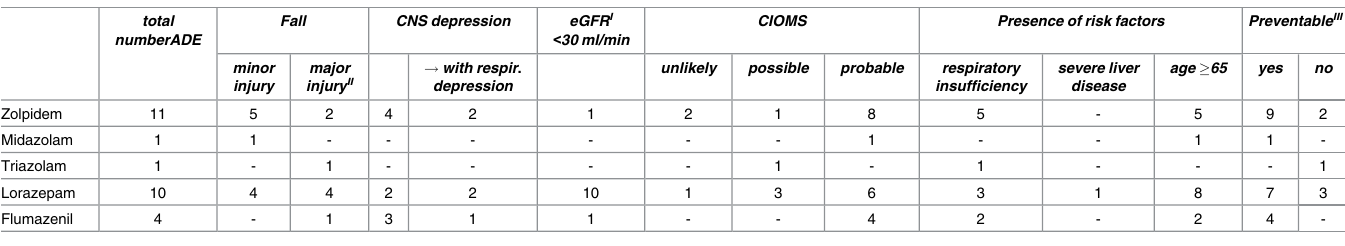
This study analyzed BDZ usage patterns, potential ME and associated ADE in the real-life set- ting of a tertiary care university hospital The use of BDZ as well as the risk for drug interactions Table 5. Cases with